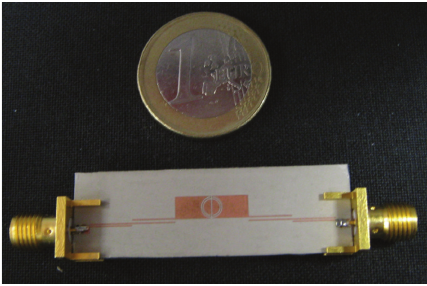
Figure 3: Fabricated prototype in Rogers RO3010 substrate, with 3.5 m D input/output connectors.